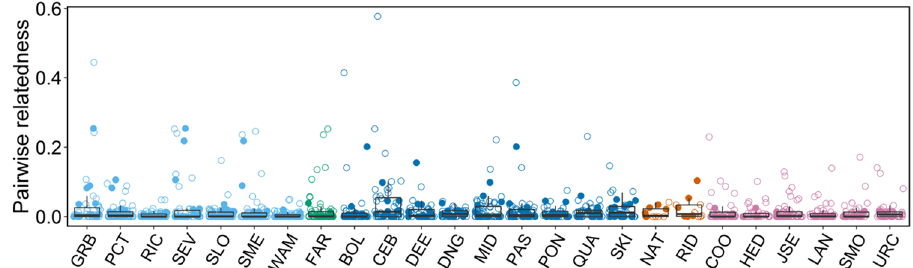
Figure 1. Distribution of dyadic relatedness values of each focal male used in the second-order GLMM with his chosen second-order alliance members and non-chosen males. Filled circles denote an individual’s chosen second-order alliance members, the non-filled circles non-chosen males. Colours correspond to second-order alliances. Boxplots represent the upper and lower quartiles ± 1.5 interquartile range as demarked by the whiskers.